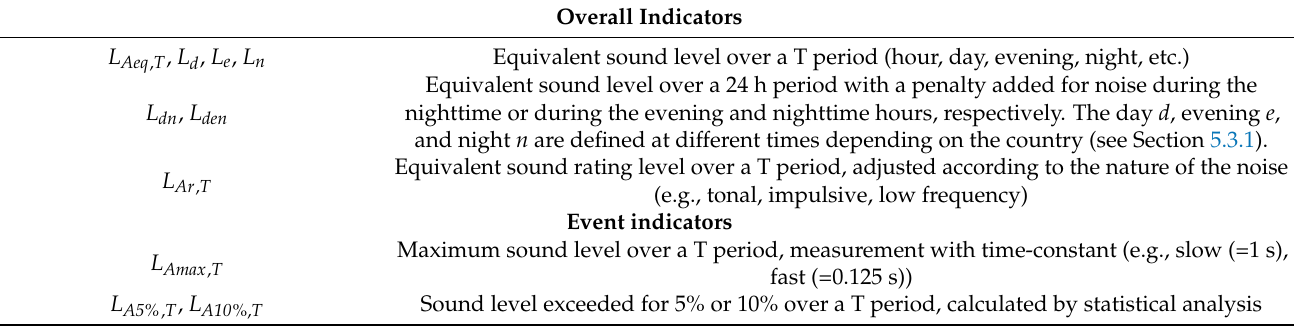
Table 1. Definition of acoustic indicators identified in noise policies and regulations (“A” stands for A-weighted dB